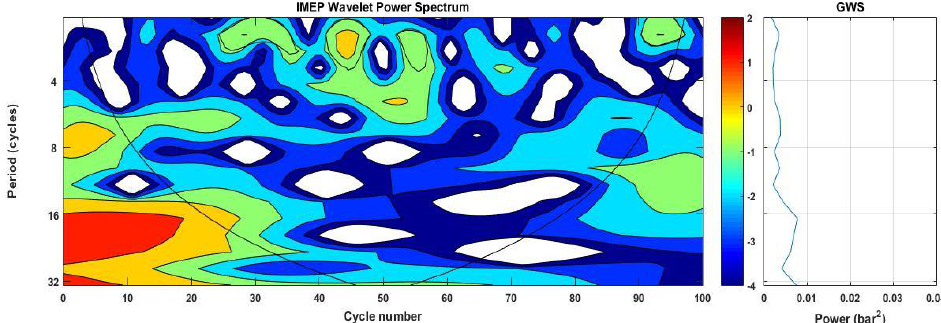
Figure 10. Wavelet analysis of IMEP (WPS and GWS), 20MPa_120BTDC_1050_Clean.